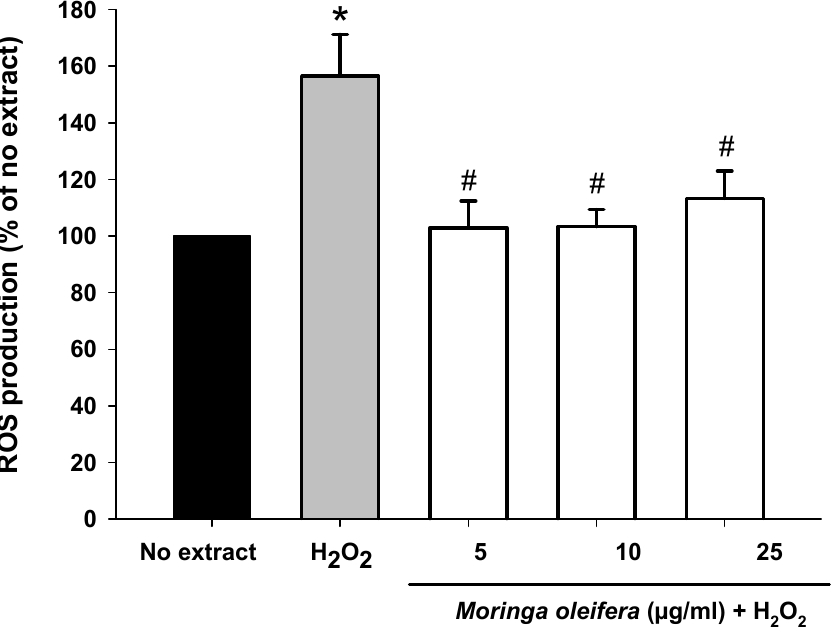
Figure 2. Effect of methanol extracts of Moringa oleifera leaf powder on intracellular ROS overproduc- tion. Cells were pretreated with moringa (5, 10 and 25 µ g/mL) for 24 h before 100 µ M H 2 O 2 for 1 h. * p < 0.05 versus no extract, # p < 0.05 versus H 2 O